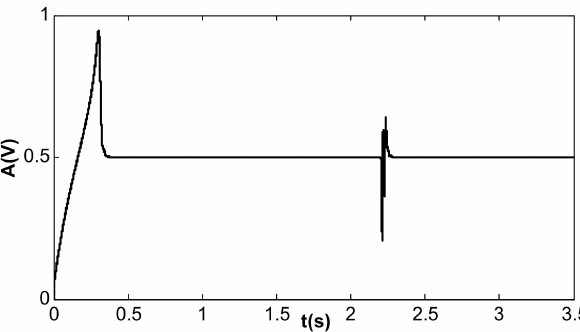
Figure 15. Detection voltage under double closed loop ( k I = 100, k II = 2).